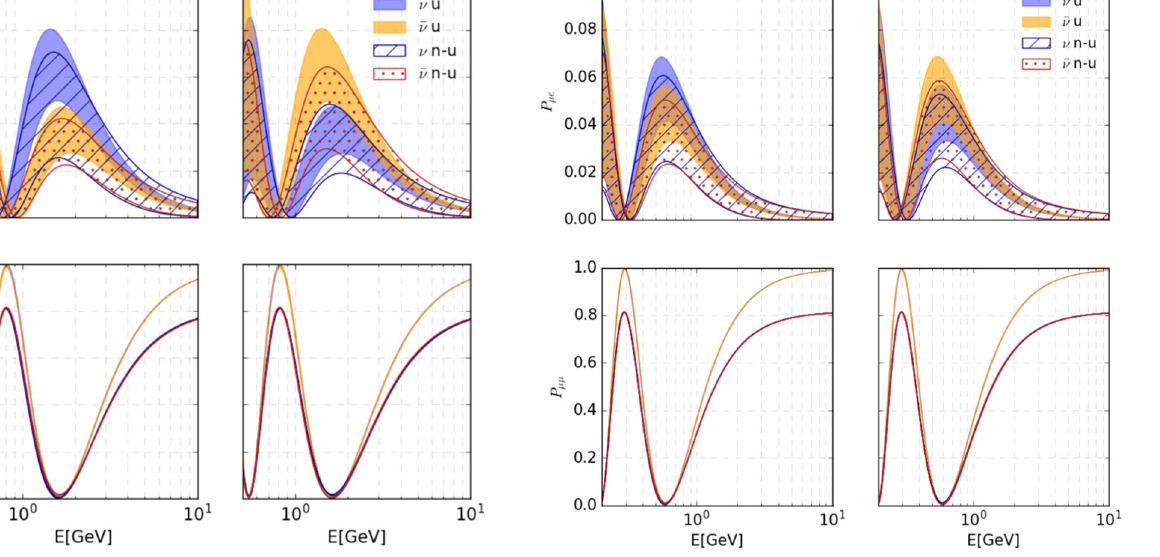
Fig. 1 Comparison between unitary and non-unitary 3 × 3 mixing of ν μ → ν ν μ → ν μ ) probabilities in the upper (lower) panel for the e ( NO ν A experiment (810 km baseline). Left (right) panel is for normal hierarchy (inverted hierarchy). The unitary CP-violating phase δ CP has been varied in its total range [− 180 ◦ : 180 ◦ ] . Non-unitary complex phase φ 10 = 0. Non-unitary parameters are fixed at their boundary values in Eq. (18) taken from Ref. [46]